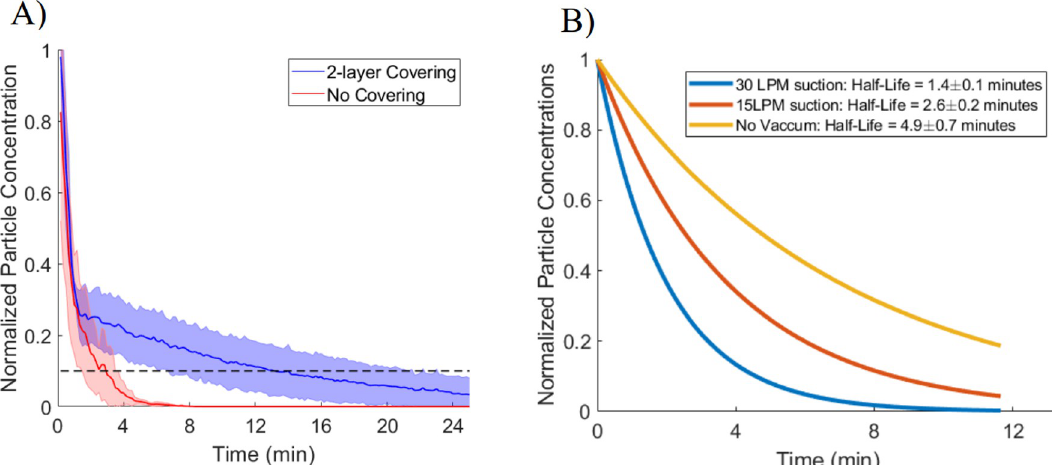
Fig 4. Particle concentration decay in the enclosure as a function of time and suction: (A) Average decay rate curves for aerosol particle number concentrations within the enclosure following a particle generation event. The no cover condition kept the provider and ventilator access holes open. The 2-layer cover condition used the furniture wrap and Steri-Drape. Shaded region shows the standard deviation from 3 replicates. The black dashed line indicates 90% particle loss. (B) Comparison of average decay rates for aerosol particle concentration when suction is applied to the enclosure. All three conditions involve a dual-covered enclosure with furniture wrap and Steri-Drape. The patient side was covered for all experiments.